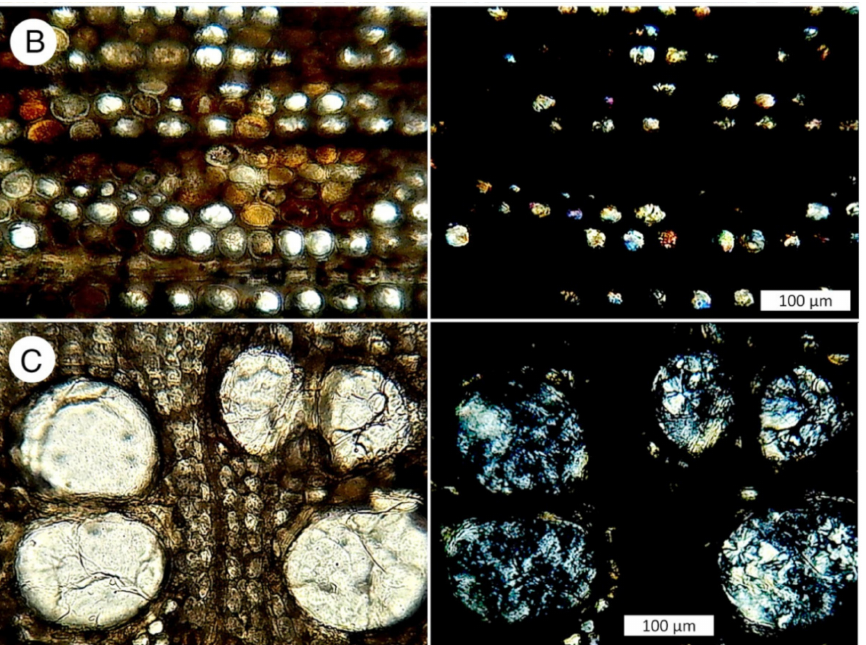
Figure 34. Photo pairs showing coexistence of multiple silica phases. In each pair, the left view shows ordinary transmitted light illumination, ( B ) is the same field of view under polarized light. Opal-A is identified by its opacity under polarized light. ( A , B ) Neogene fossil woods from Guatemala [110]. ( A ) Transverse view, showing cell walls mineralized with opal-A, and chalcedony filling cell lumen. ( B ) In another area on the same thin section, many cell lumen are filled with opal-A, brown in ordinary illumination, opaque in polarized light). Other neighboring cells contain chalcedony. ( C ) Miocene angiosperm wood from Yakima Canyon, central Washington, USA. Small cells are mineralized with opal; vessels contain chalcedony. Specimen courtesy of Tad Dillhoff [111].